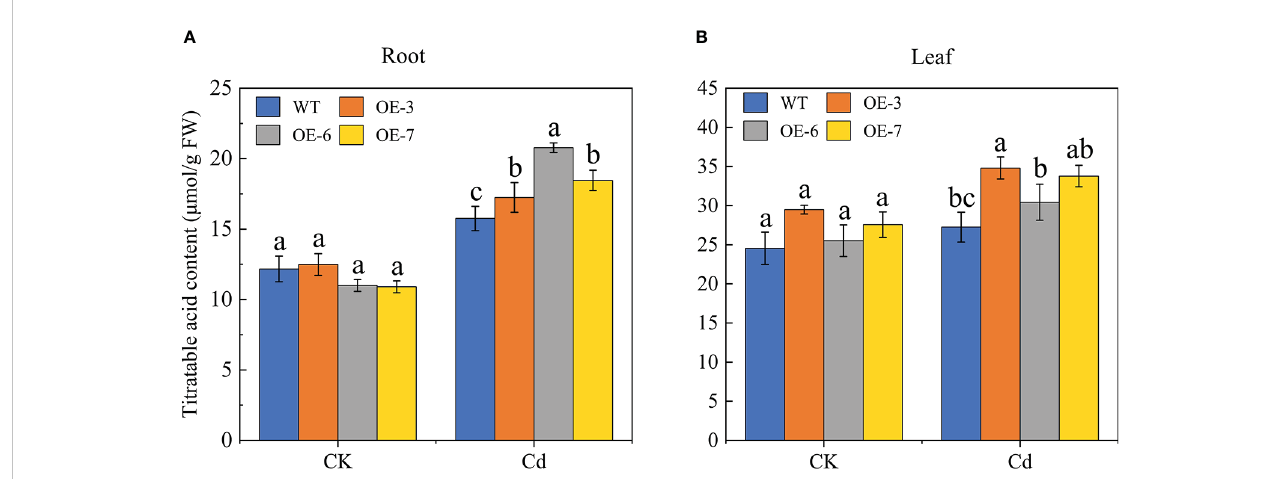
FIGURE 7 Titratable acid contents of the WT and SpCTP3 -overexpressing transgenic poplar roots and leaves treated with 100 m mol·L − 1 Cd for 30 days. (A) Root titratable acid contents. (B) Leaf titratable acid contents. Data are presented as the mean ± SD of three independent replicates. Different letters above bars indicate signi fi cant differences among treatments ( p < 0.05).